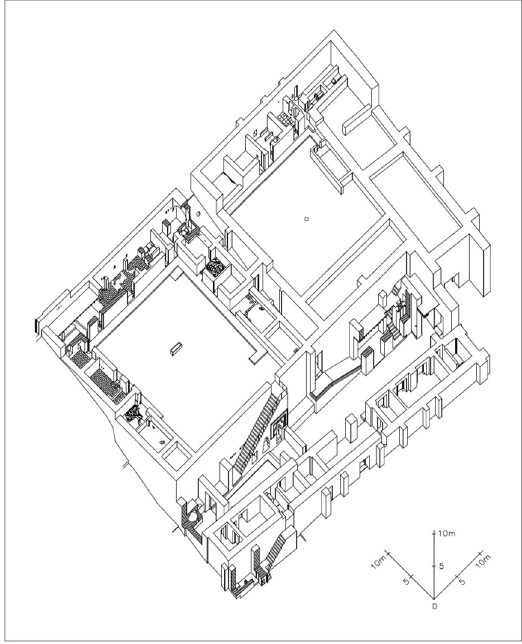
Figure 18. Buildings Nos. 6, 7, 9 and 10. Axonometry (Vallejo 2010, p. 282, pl. 226).